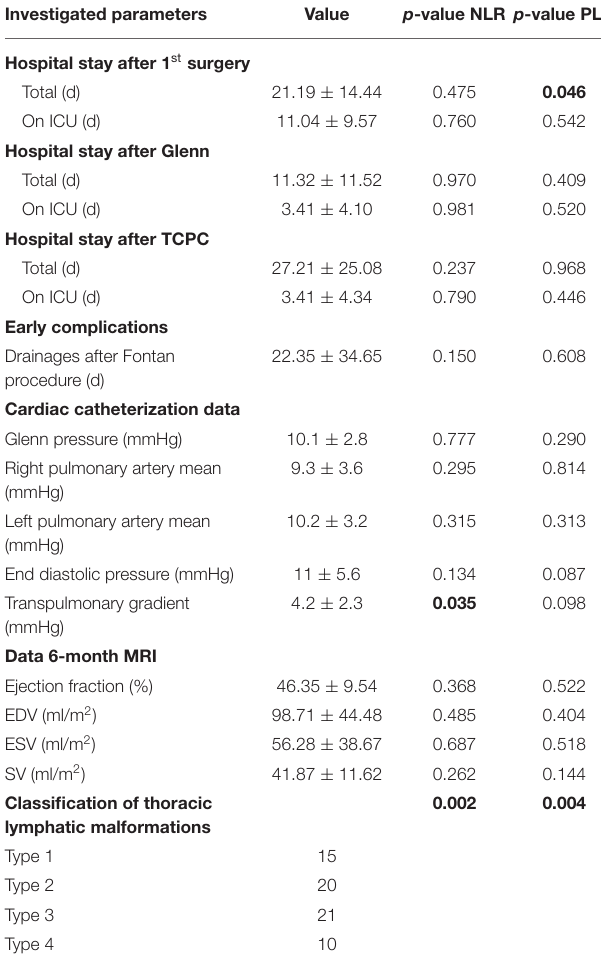
TABLE 2 | Outcome